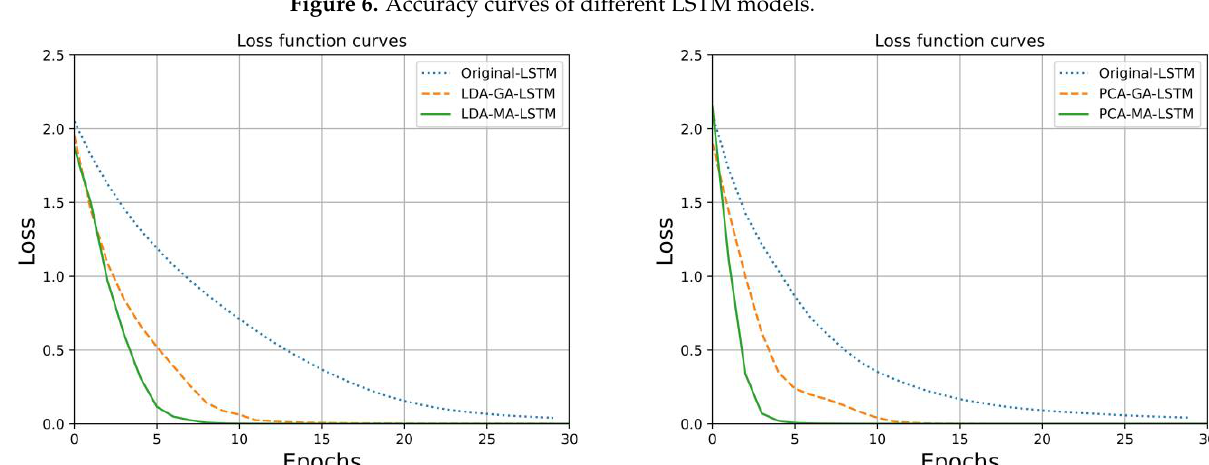
Figure 7. Loss curves of different LSTM models.